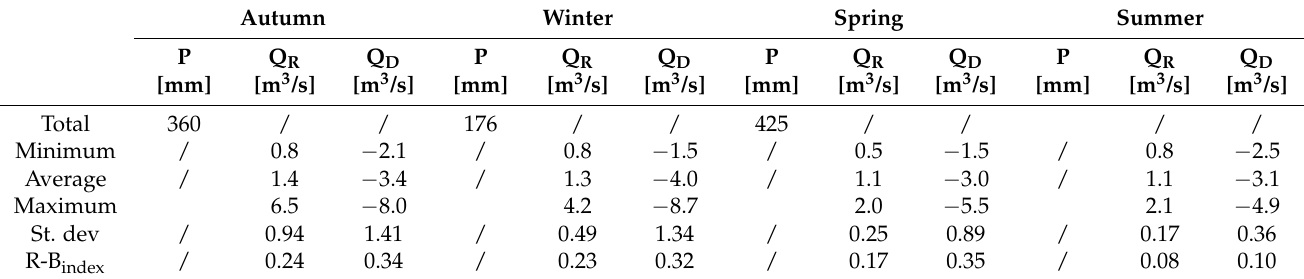
Table 3. Statistical parameters of the seasonal recharge/discharge and rainfall data.